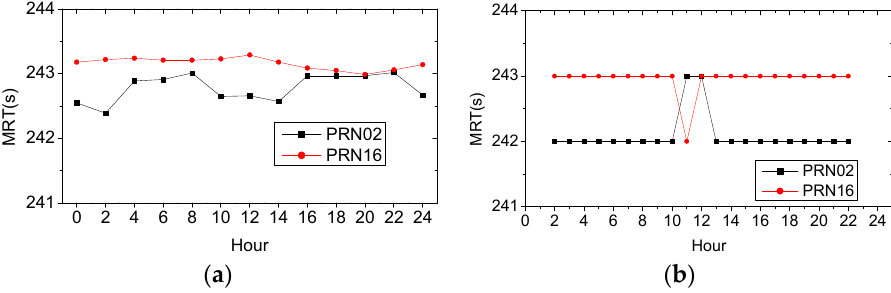
Figure 10. MRT estimates for PRN02 and PRN16 on DOY 344, 2014. ( a ) MRT estimates derived (every two hours) by ORTM; ( b ) MRT estimates derived (every hour) by ARTA. Table 4. MRT estimates derived by RCM with different length of residual time series for PRN02 and PRN16 on DOY 344, 2014. The full lengths of residual time series of PRN02 and PRN16 are about 7.1 h.